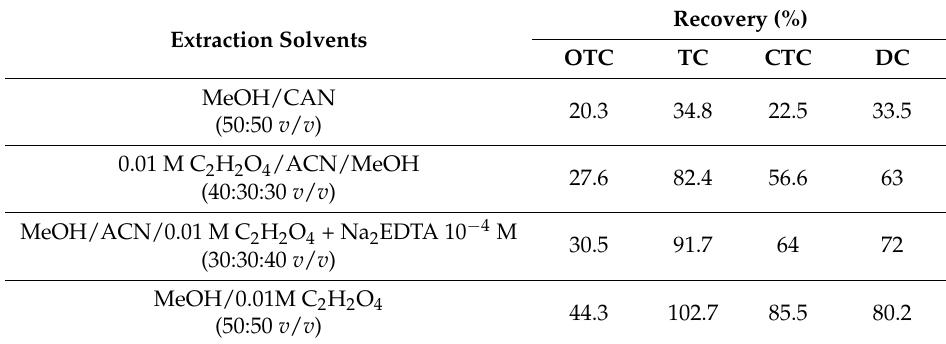
Table 1. Recoveries from the optimization of the QuEChERS extraction